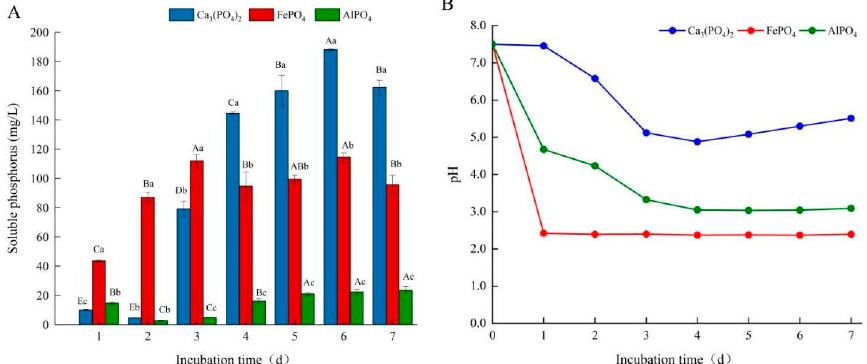
Figure 3. Changes in soluble phosphorus concentration ( A ) and pH value ( B ) in fermentation broth with different phosphorus sources. Different capital letters represent the significant ( p < 0.05) difference of the soluble phosphorus concentration under the same phosphorus source at different cultivation times; different lowercase letters indicate that the soluble phosphorus content in the culture supernatant of different phosphorus sources is significantly ( p < 0.05) different under the same culture